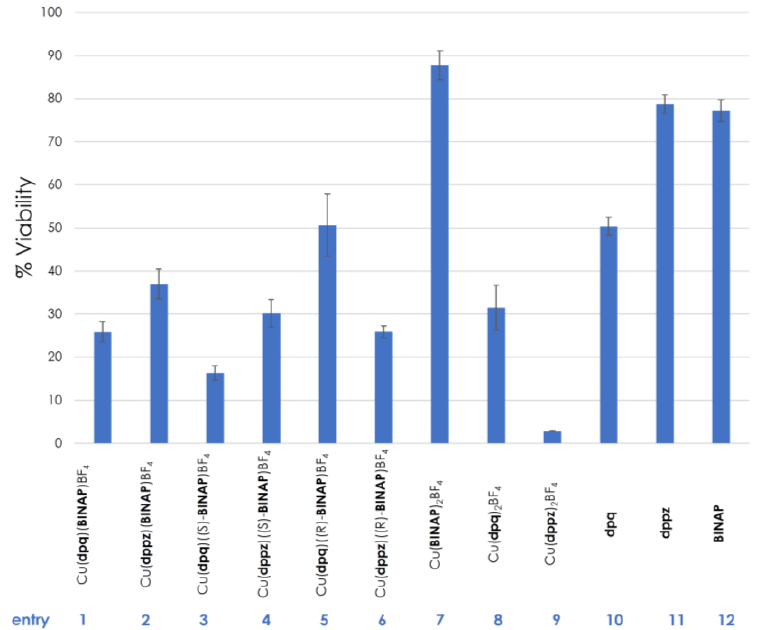
Figure 8. Viability of MDA-MB-231 cells at 5 µM. MDA-MB-231 cells were seeded at the density of 7000 cells per well in 96-well plates; plates were incubated overnight. The cells were then treated with growth media containing 5 µM of the copper complexes (entries 1 – 9 ) or controls (entries 10 – 12 ) and allowed to incubate at 37 °C for 72 h. The viabilities of cells were finally determined by MTT assay and converted to percentages. Data are an average of three different experiments.